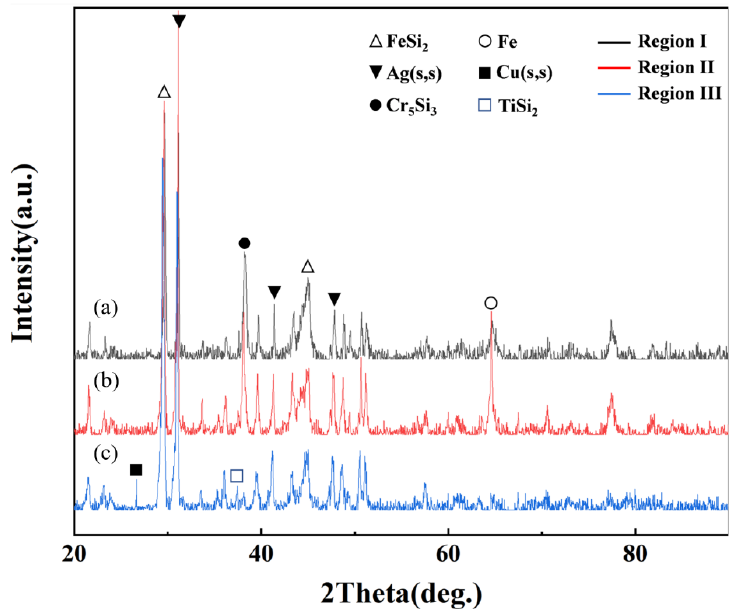
Figure 2. The typical microstructure of PS-SiC-stainless steel joint: ( a ) the microstructure of brazing seam; ( b ) complete microstructure of joint; and magnification drawing of ( c ) Region I; ( d ) Region II; and ( e ) Region III.